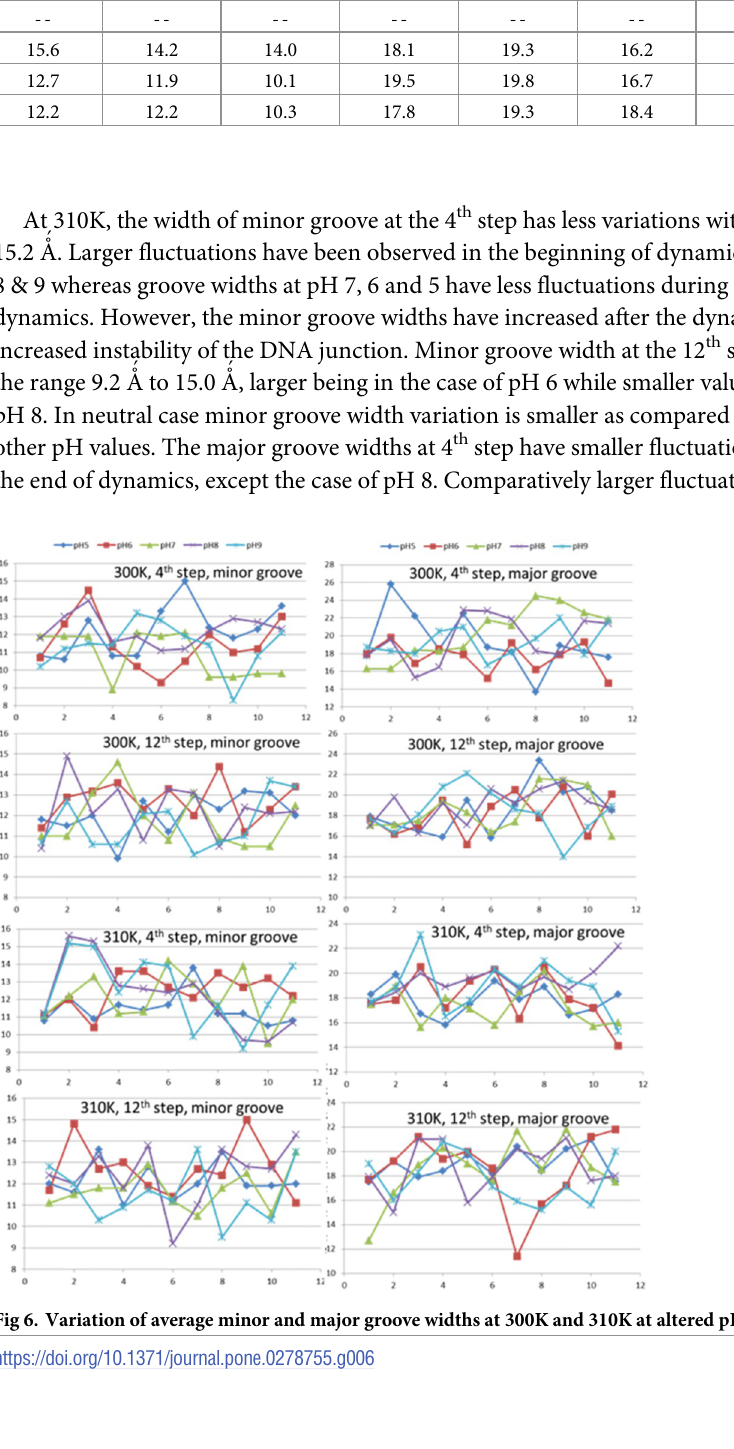
Fig 6. Variation of average minor and major groove widths at 300K and 310K at altered pH values.